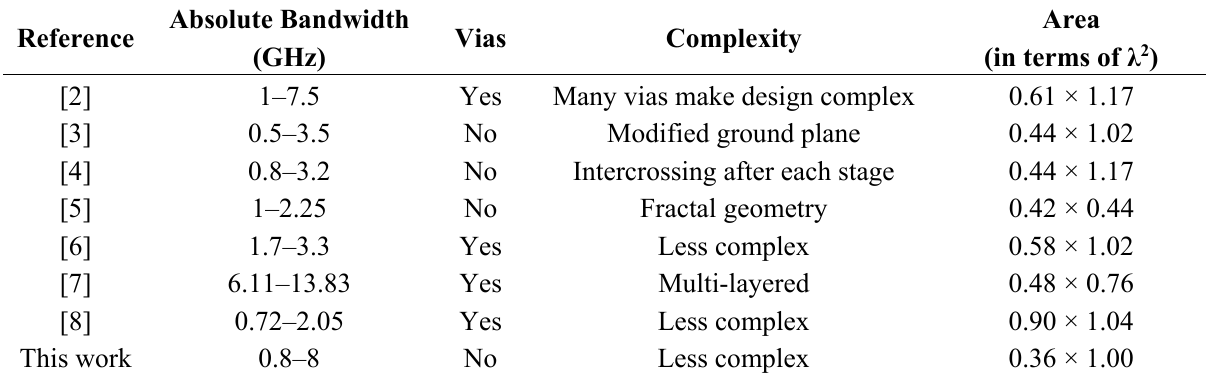
Table 2. Performance comparison of the proposed balun with recent